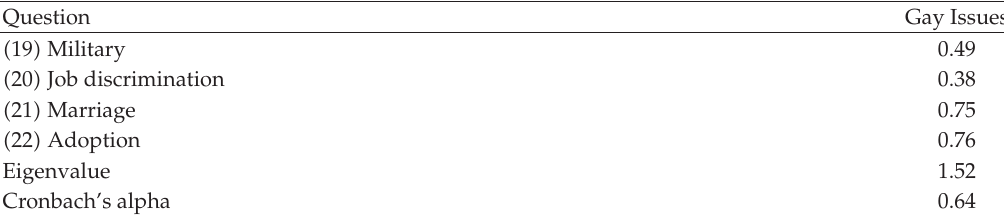
Table 2: Factor loadings for gay